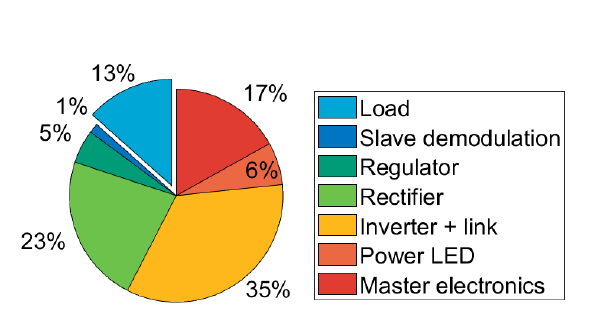
Figure 14. Estimate of the power lost in the various